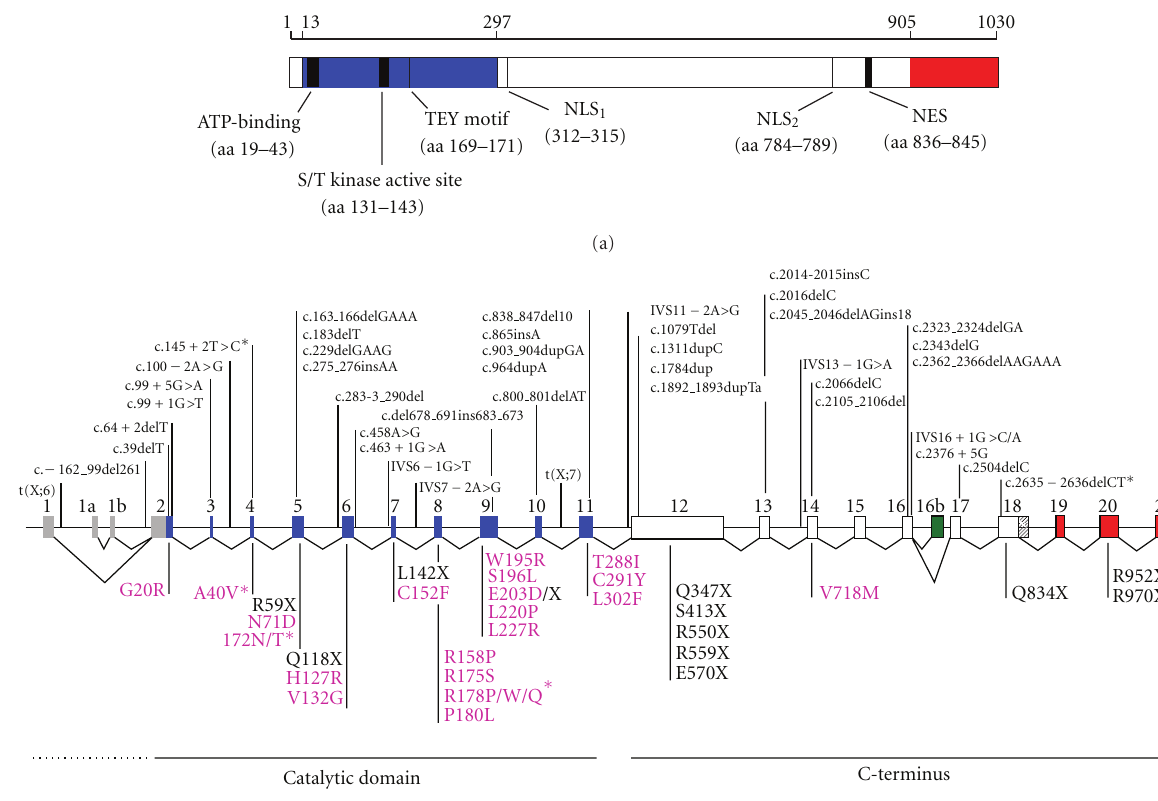
Figure 2: Pathogenic CDKL5 mutations. (a) Schematic representation of CDKL5 115 with the functional domains and signatures indicated. NLS: nuclear localization signal; NES: nuclear export signal. (b) All mutations in CDKL5 reported to date are indicated corresponding to their location within the gene. Mutations shown above the CDKL5 gene are deletion and frame shift mutations as well as splice variants indicated with cDNA nomenclature. Missense and nonsense mutations (fuchsia and black, resp.) are represented with amino acid nomenclature below the CDKL5 gene. ∗ : recurrent mutations; ◦ : uncertain pathogenicity. The indicated mutations have been referred by: t(X;6) [2];